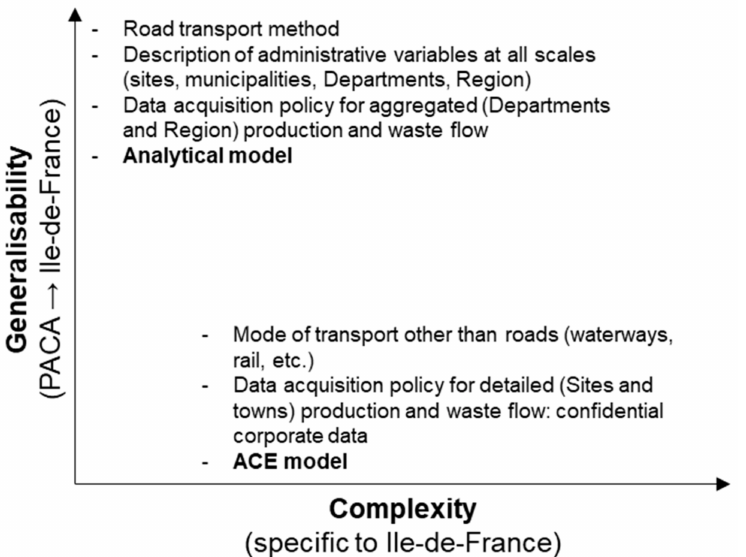
Figure 8. The compromise between generalization and complexity in constructing the Ile-de-France region model from the data that can be transposed from the PACA region model. Source: The initial diagram (in bold) is adapted from